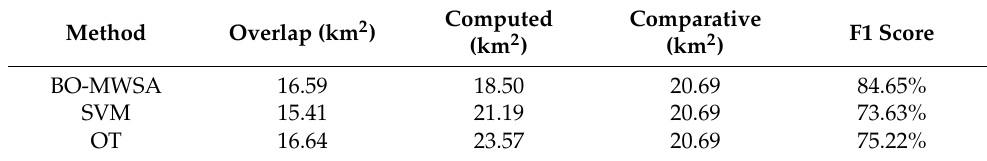
Table 1. F1 scores of BO-MWSA, SVM, and OT.